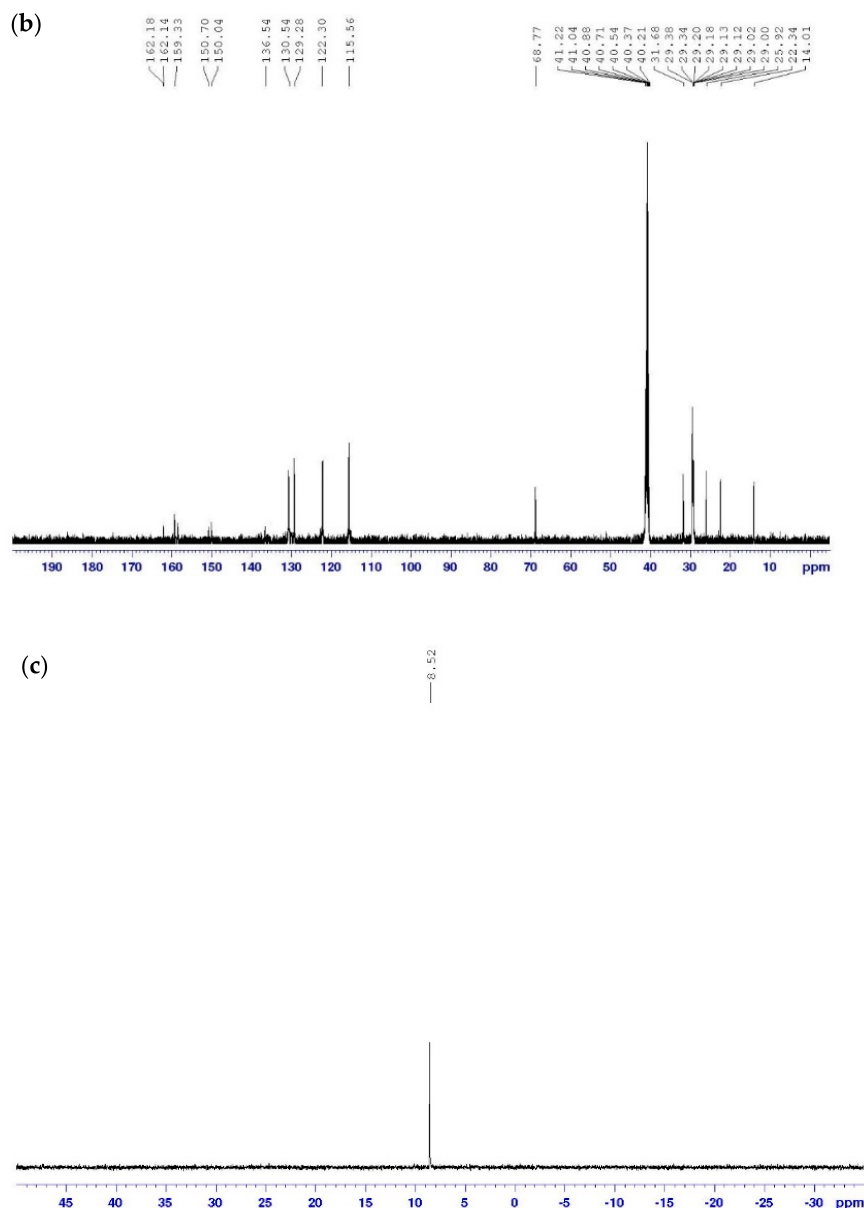
Figure 5. ( a ) 1 H NMR, ( b ) 13 C NMR, and ( c ) 31 P NMR spectra of compound 4a .